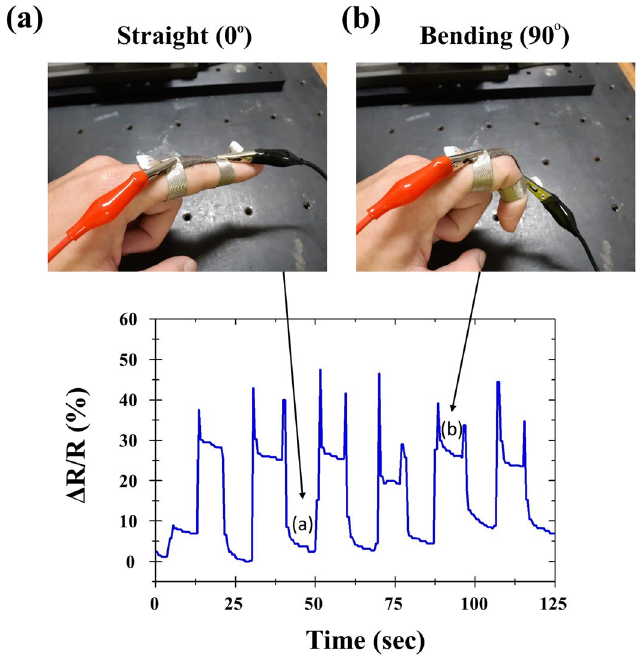
Figure 5. Illustration of a textile based strain sensor for human motion sensing. The contrast of relative resistance variation between finger bending at 0 ° ( a ) and 90 ° ( b ) is over 25. The spikes are due to instabilities of human factors and the nonlinear response upon sudden motion changing. Similar observations were also made in 52–54 .